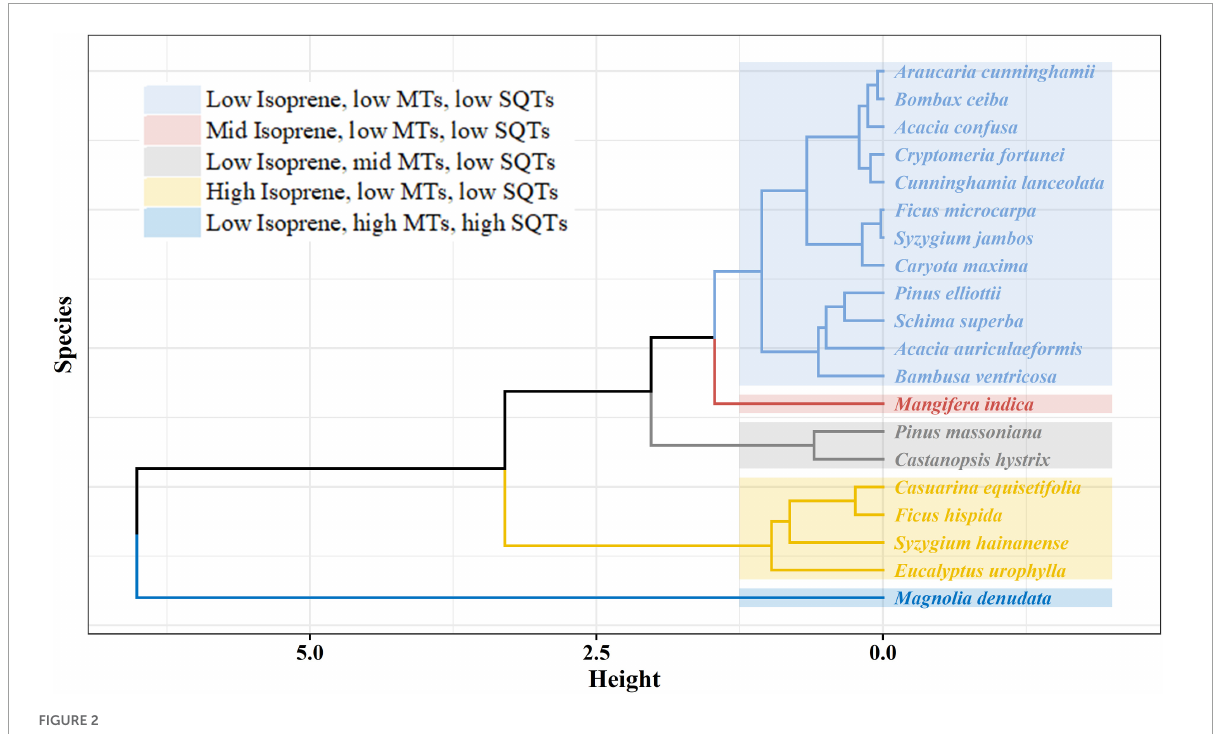
FIGURE2 Tree species classification based on cluster